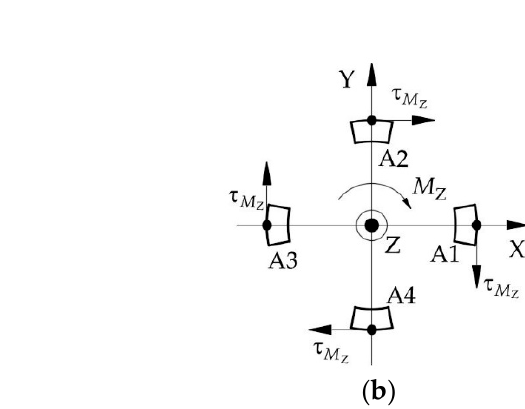
Figure 7. The shear stress’ direction of the points in the outside surface of layer A: ( a ) under the force F X ; ( b ) under the torque M Z . F X ; ( b ) under the torque M Z .